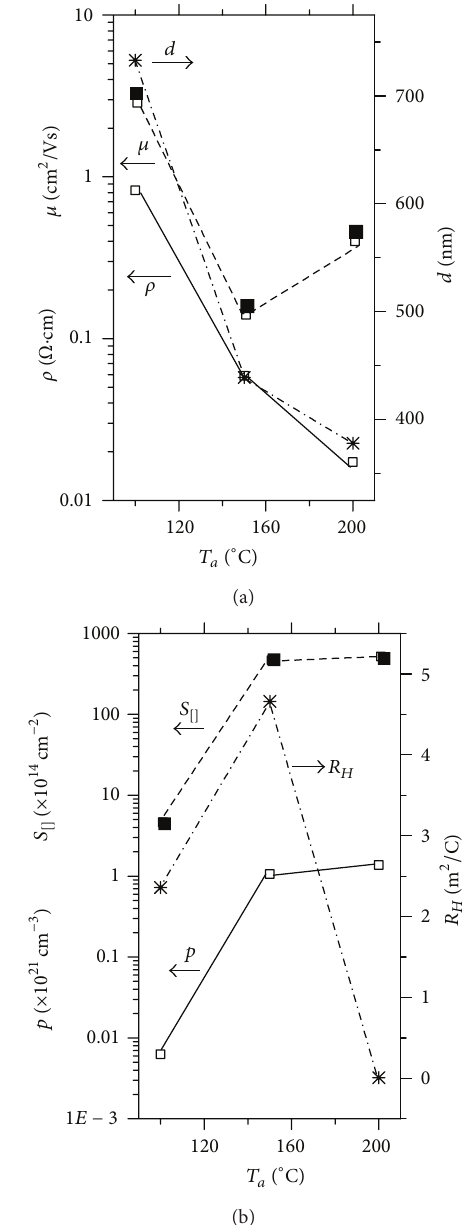
Figure 5: (a) Resistivity ( 𝜌 ), mobility ( 𝜇 ), and thickness ( 𝑑 ) as a function of the annealing temperature ( 𝑇 ). (b) Sheet concentration ( 𝑆 [] ), holes concentration ( 𝑝 ), and Hall coefficient ( 𝑅 𝐻 ) versus 𝑇